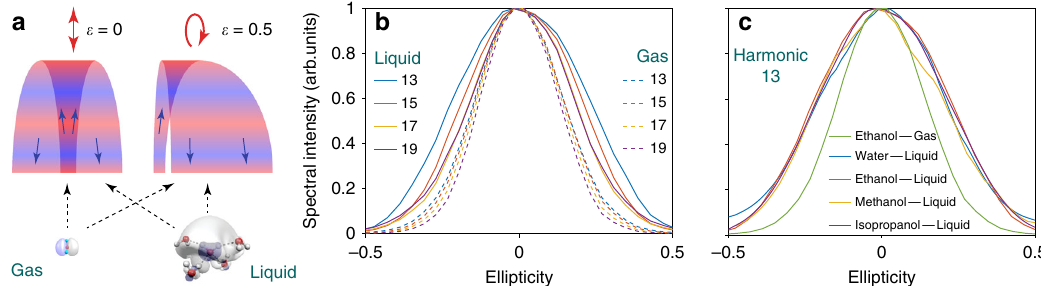
Fig. 5 Ellipticity dependence of HHG from liquids. a Schematic illustration of valence orbitals of a water monomer and a water pentamer cluster (representative sub – unit of liquid water 50 ) and the laser – driven continuum – electron wave packet for different ellipticities of the driving fi eld. The color gradient illustrates the wave nature and propagation of the electronic wavepacket. ϵ is the ellipticity, with 0, 1 corresponding to linearly and circularly polarized electric fi elds, respectively. b Ellipticity dependence of the high – harmonic intensities, for different harmonic orders (H13 to H19) emitted from liquid – phase or gas – phase ethanol (solid and dashed lines, respectively) under identical experimental conditions. c Ellipticity dependence of H13 emitted from different liquids in comparison to gas –